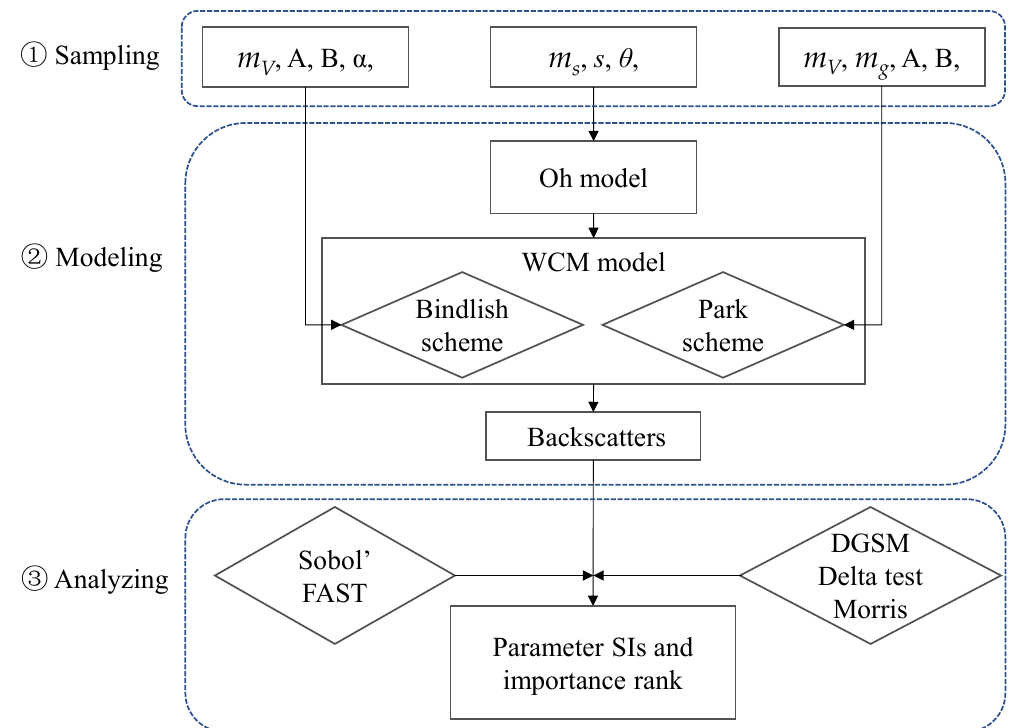
Figure 1. Flowchart of the presented global SA procedure.